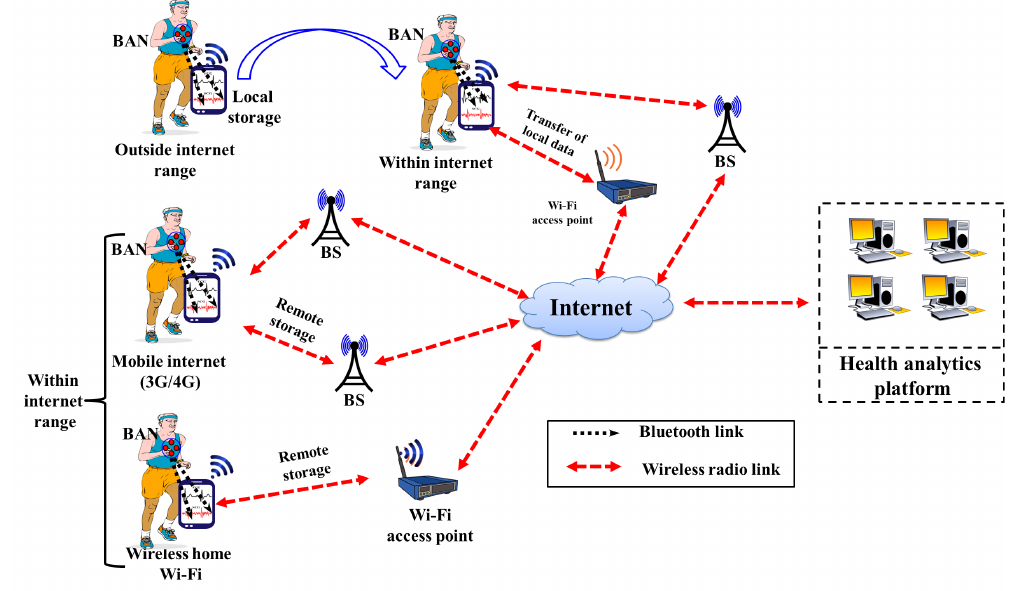
Figure 3. Communication framework between BAN and HAP.